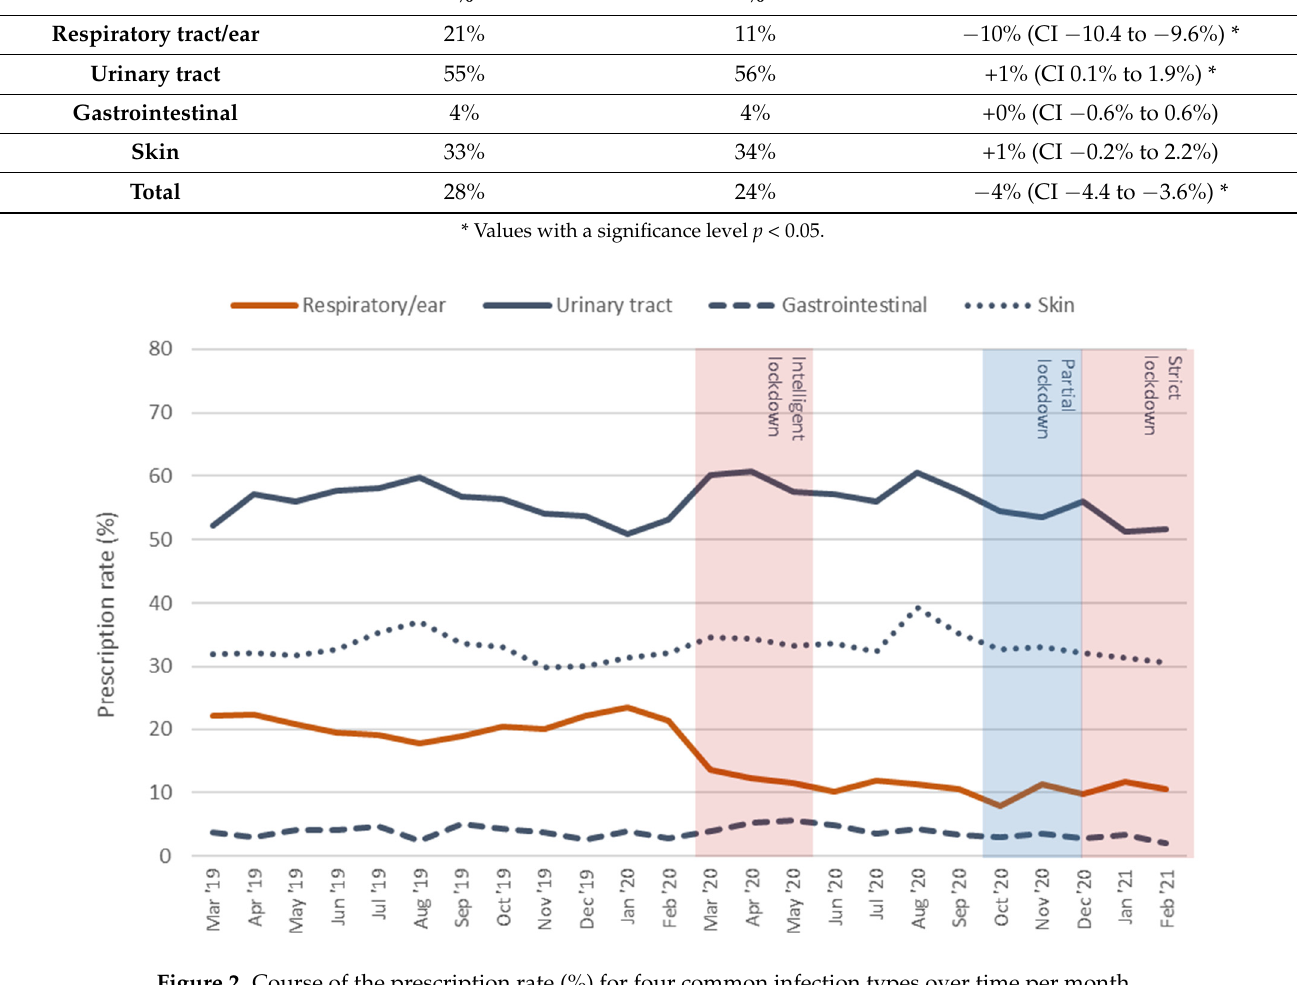
Table 3. Relative risks of respiratory/ear infection episodes (total and with antibiotic prescription) and prescription rates pre-pandemic and during the first pandemic year, per age category.